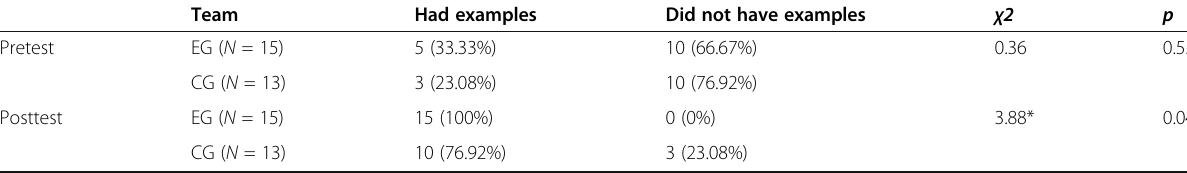
Table 5 Preservice technology teachers ’ performance: providing examples of engineering design thinking Team Had examples Did not have